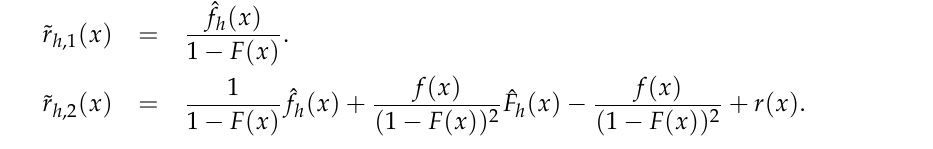
(first box), h SMCV l